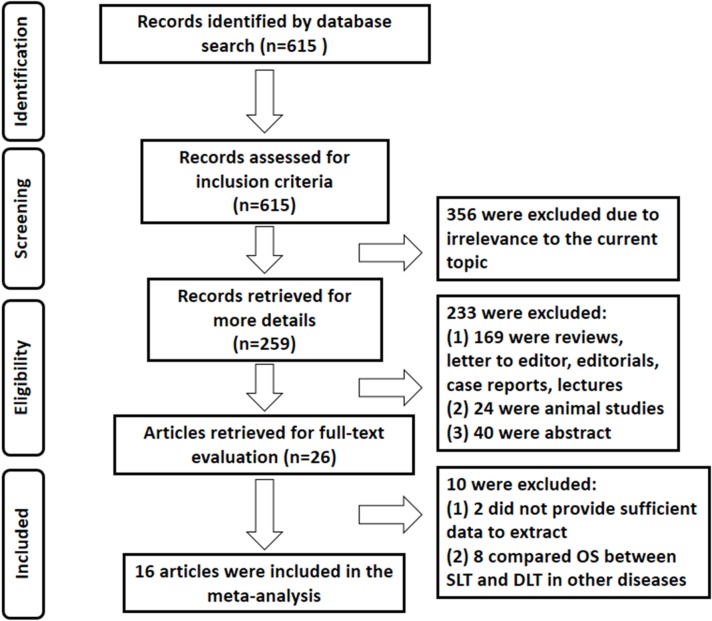
Flow chart of selection process for eligible articles.